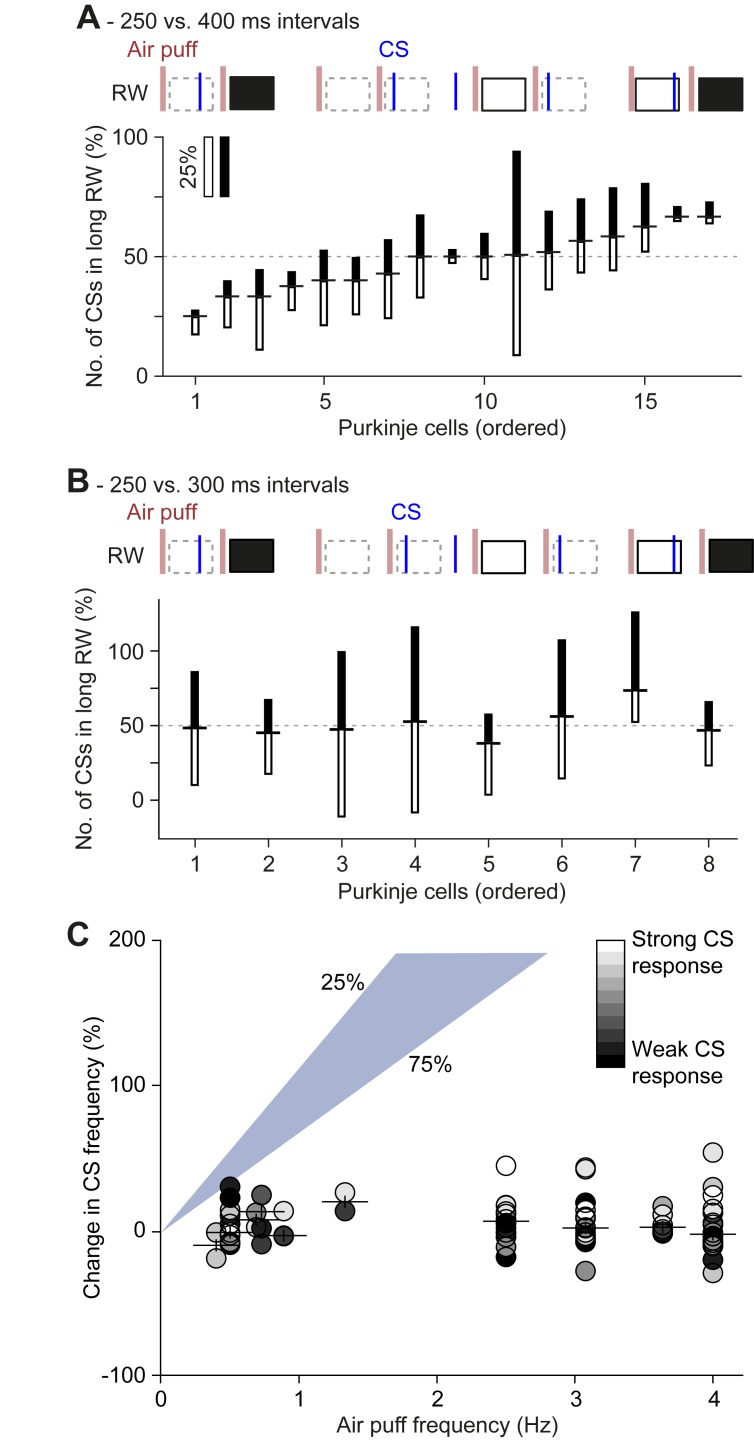
No phase-dependent spiking probabilities observed in vivo.(A) In order to test the impact of the presumed phase of the inferior olivary neurons in vivo, we applied a “gallop” stimulation pattern, alternating short (250 ms) and long (400 ms) intervals. Air puffs were delivered to the whisker pad. Complex spikes were counted in response windows (RWs) 20–200 ms post-stimulus and cells were sorted as a function of the ratio between the numbers of complex spikes in short and long intervals (indicated as horizontal dash between filled and empty bars). In this analysis, we included only the RWs that followed an RW with at least one complex spike; i.e. the RWs indicated by a dashed border were ignored. For each Purkinje cell the relative response probabilities for the long and short intervals are illustrated as the length of the filled and open bars, respectively. None of the Purkinje cells showed a significant difference in the response probability between the two intervals (all p > 0.05 on Fisher’s exact test). (B) The same for the alternation of 250 and 300 ms intervals, showing even less response bias than in A. (C) If sensory stimulation triggers complex spikes, one would expect that a higher frequency of stimulation would lead to a higher frequency of complex spikes. However, such a relation was absent. For this analysis, we included only sensory-responsive Purkinje cells of which the complex spike response exceeded a bootstrap-derived 99% probability threshold. The gray scaling of the symbols indicates the response probability. Purkinje cells displaying a higher complex spike response rate had a slightly increased firing rate upon higher stimulus frequencies, but this was far from the expected increase (based upon a linear relationship; the shaded area indicates the 25–75% range).